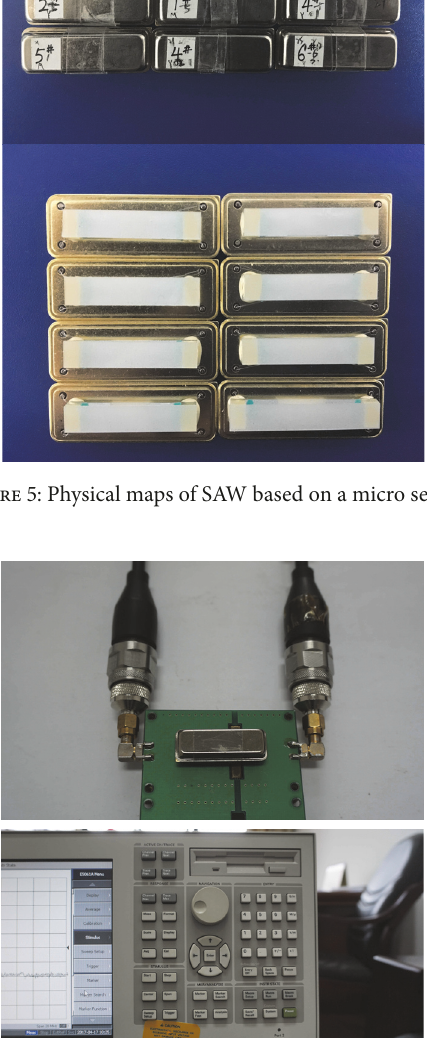
is adopted to eliminate the interference of temperature, humidity, and noise, as shown in Figure 8.